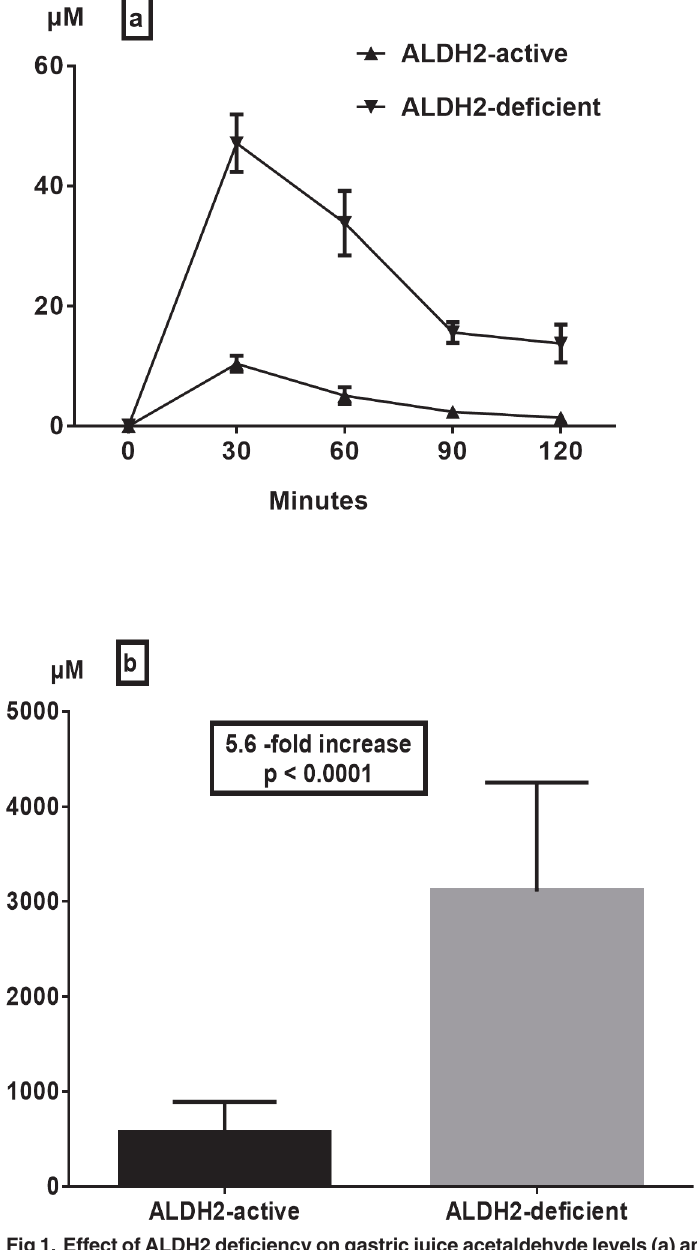
Fig 1. Effect of ALDH2 deficiency on gastric juice acetaldehyde levels (a) and areas under the curve (b) after intragastric infusion of ethanol (15 vol%, 0.5 g/kg) (means ± SEM).